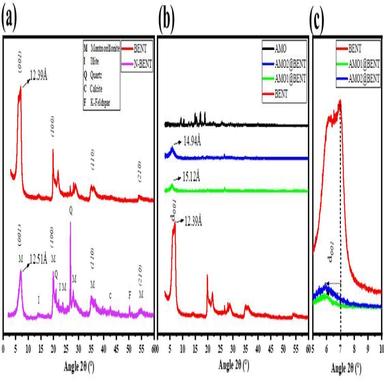
XRD patterns of (a) N-BENT and BENT; (b) BENT, AMO1@BENT, AMO2@BENT and AMO and (c) BENT, AMO1@BENT and AMO2@BENT.